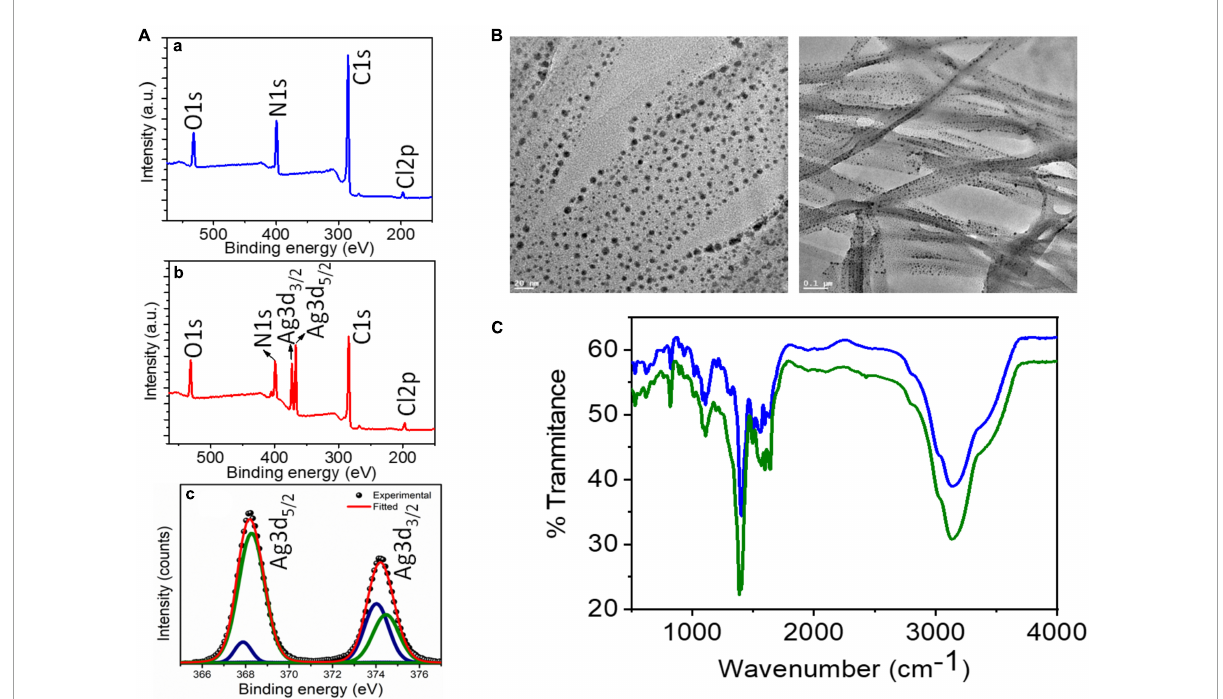
FIGURE2 Batch characterization of AD-L@Ag(0): (A) XPS analysis: (a,b) XPS survey spectra of AD-L (blue trace), and AD-L@Ag (red trace) respectively. (c) Represents high-resolution deconvoluted spectra collected in the Ag 3d region for AD-L@Ag. (B) TEM analysis: TEM images of metallogel from AD-L@Ag(0) showing the gel fibers with in situ formed silver nanoparticle at 20 nm and 0.1 µ m. (C) FT-IR analysis: FT-IR analysis of AD-L@Ag(0) in powder (blue line) and the gel phase (green